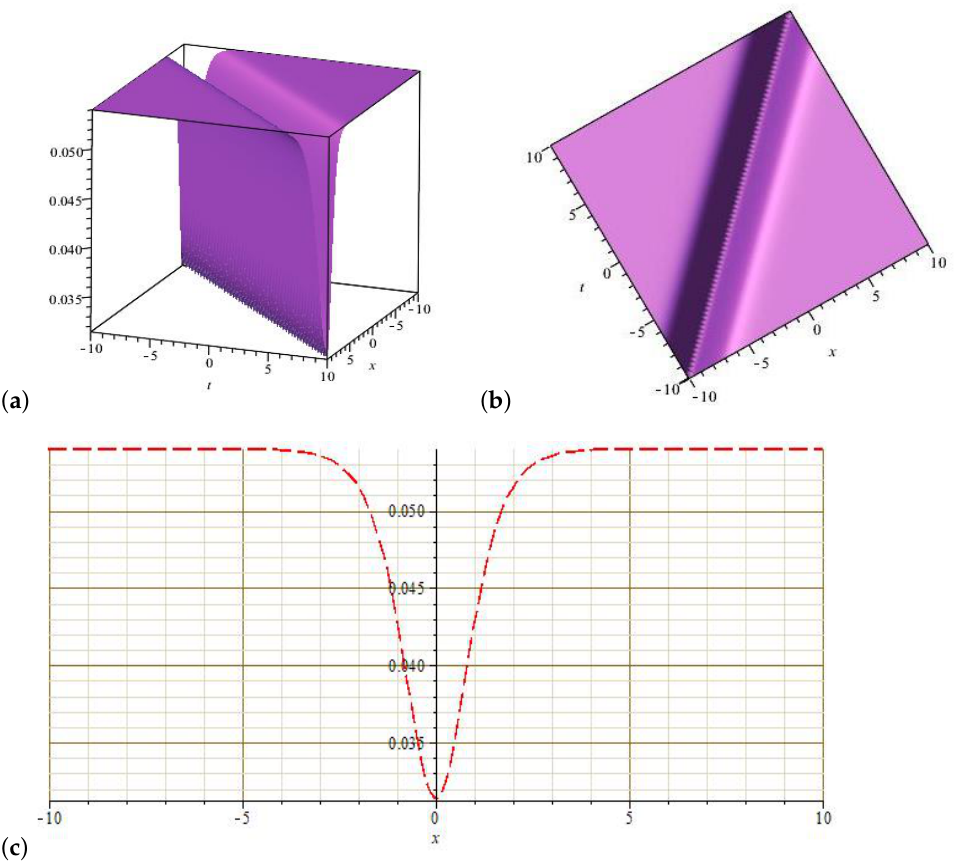
Figure 4. Graphical view of | Q 16 ( (cid:36) ) | for a 1 = 0.04, v = 2, (cid:101) = 1, a 0 = 0.06, w = 0.7, u = 0.3: ( a ) 3D plot, ( b ) contour plot, and ( c ) 2D plot at t =